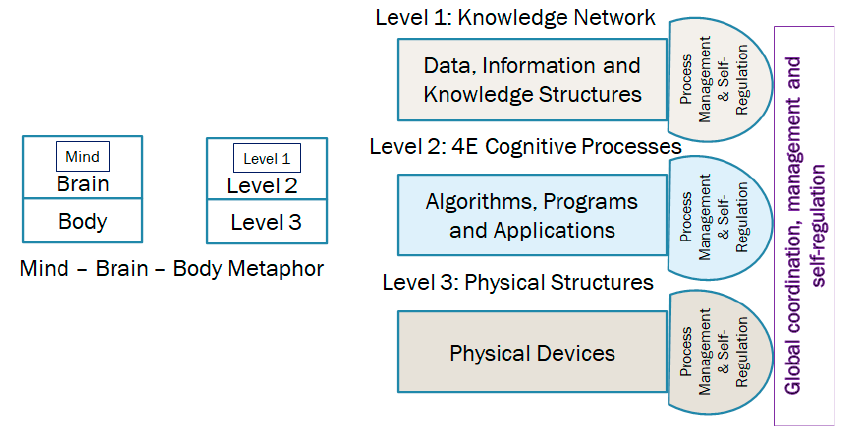
Figure 4. Triadic automata managing hardware, software, and